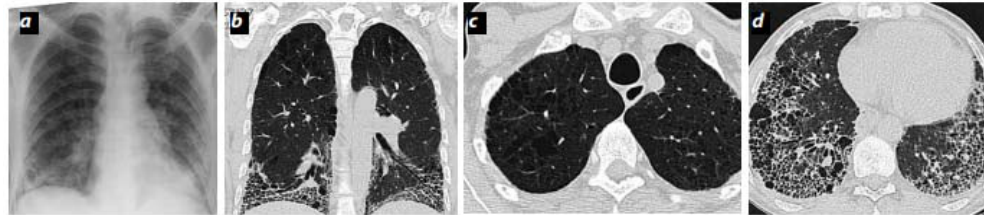
Figure 2. Combined pulmonary fibrosis and emphysema (CPFE). ( a ) Bilateral chest radiography with basal reticular opacities. Increased diameter of the interlobar artery (pulmonary hypertension). ( b – d ) High-resolution computed tomography (HRCT) axial slices (apexes and bases) and coronal reconstruction. Areas of low centrilobular density without defined wall with apical predominance (centrilobular emphysema). Honeycombing is basal, bilateral, and symmetrical with loss of volume of the lower lobes. Traction bronchiectasis is observed.